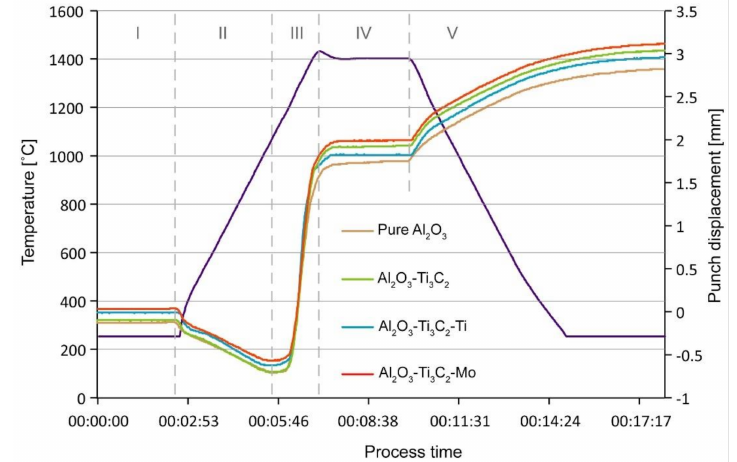
Figure 5. Spark plasma sintering (SPS) curves of Al 2 O 3 -1 wt.% Ti 3 C 3 /Ti 3 C 2 -Ti/Ti 3 C 2 -Mo composites and pure Al 2 O 3